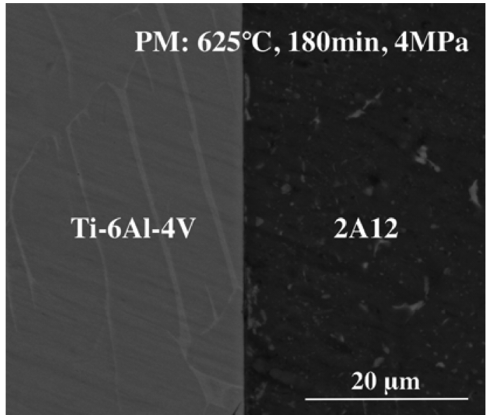
Figure 3: The SEM micrograph in interface region of Ti/Al bonds obtained by